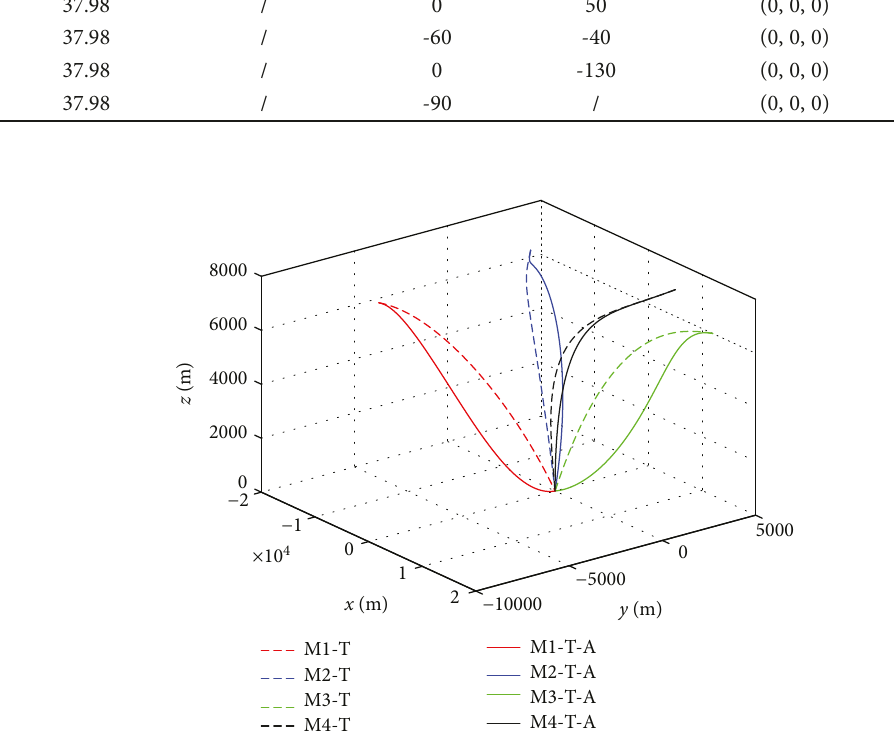
Figure 11: 3D trajectories with impact time and angle control by